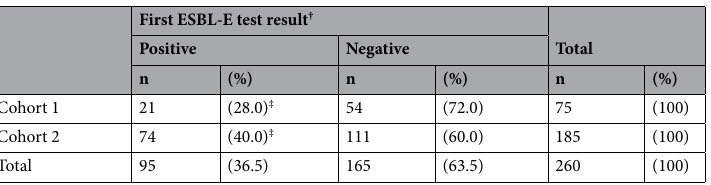
Table 2. ESBL-E carriage statuses among residents in Cohort 1 and Cohort 2 (N = 260; Analysis Part 1). ESBL-E, extended-spectrum β-lactamase-producing Enterobacterales. † Performed < 1 month after study onset or initiation of residence. ‡ Chi-square test: p < 0.01.